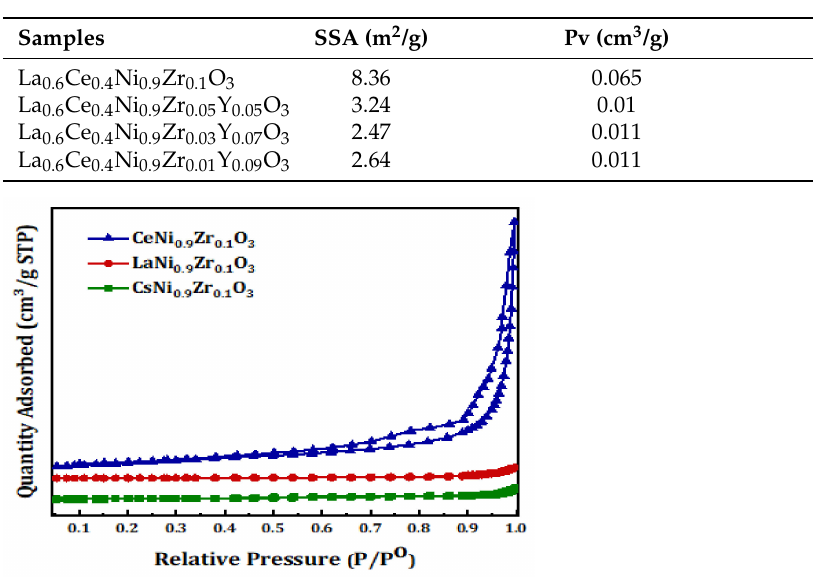
Figure 1. Nitrogen physisorption isotherms of catalyst MNi 0.9 Zr 0.1 O 3 (M = La, Ce, and Cs).